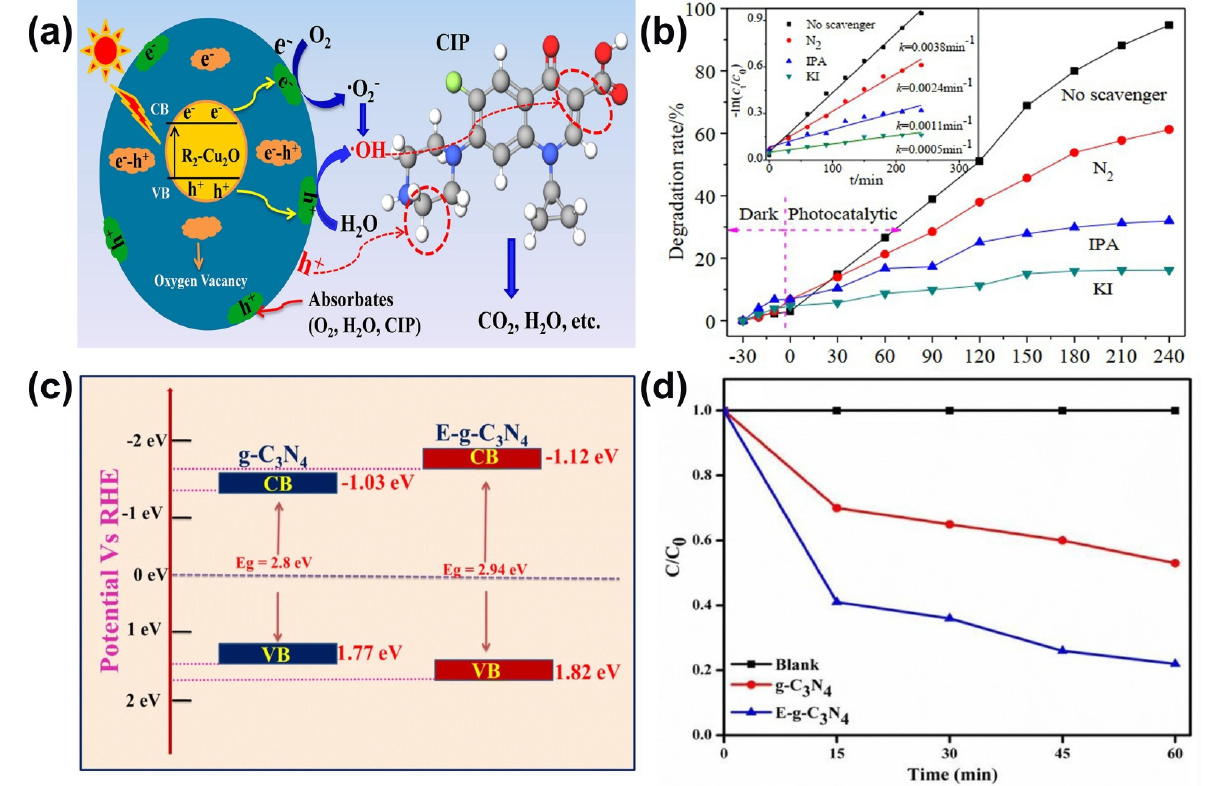
Figure 7. ( a ) The schematic diagram of the photocatalytic mechanism for the Zn-doped Cu 2 O ( b ) Photocatalytic activity of R 2 -Cu 2 O with different scavenges, inset is degradation rate of ciprofloxacin. (Reproduced with permission from [80], copyright 2019, Elsevier) ( c ) Diagram of band gap structure of bulk and exfoliated g-C 3 N 4 ( d ) Photocatalytic degradation of ciprofloxacin over g-C 3 N 4 as well as exfoliated g-C 3 N 4 . (Reproduced with permission from [81], copyright 2019, Springer Nature).